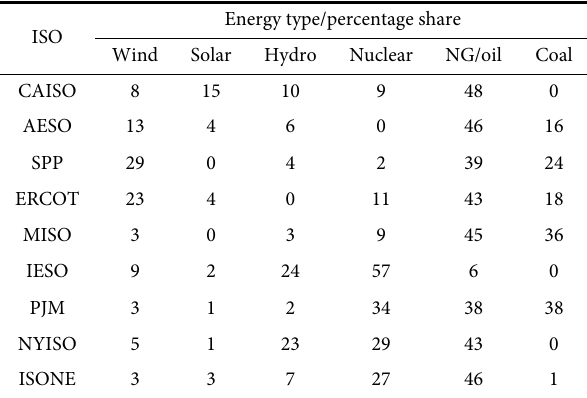
Table 1 Percentage system energy generation by fuel type in